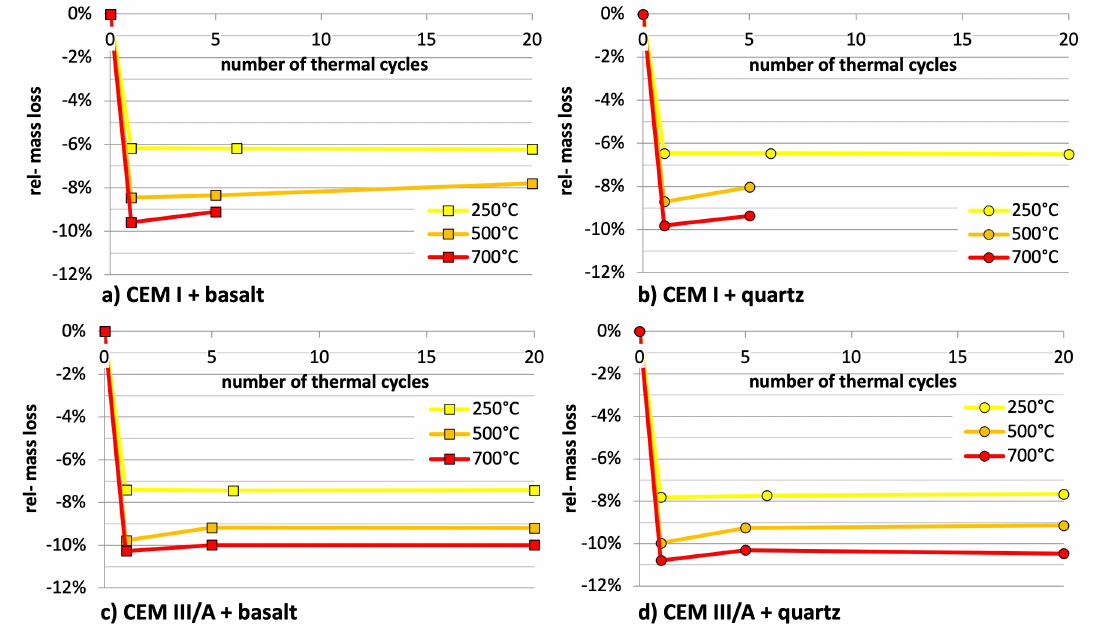
Figure 6. Mass loss induced by cyclic heating for all tested